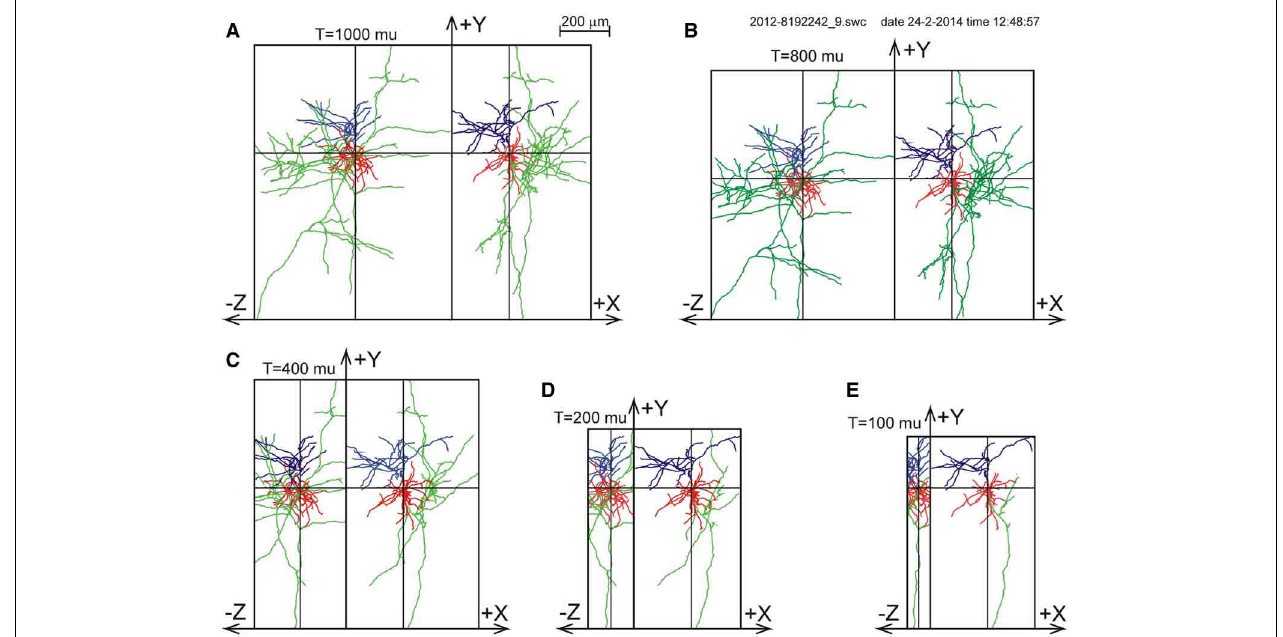
FIGURE 3 | Illustration of slicing of a NETMORPH neuron for slice thicknesses T of (A) 1000 µ m, (B) 800 µ m, (C) 400 µ m, (D) 200 µ m, and (E) 100 µ m. The neurons are plotted as projections onto the XY plane and onto the YZ plane. Neurons have their somata in the center of the slice and are aligned